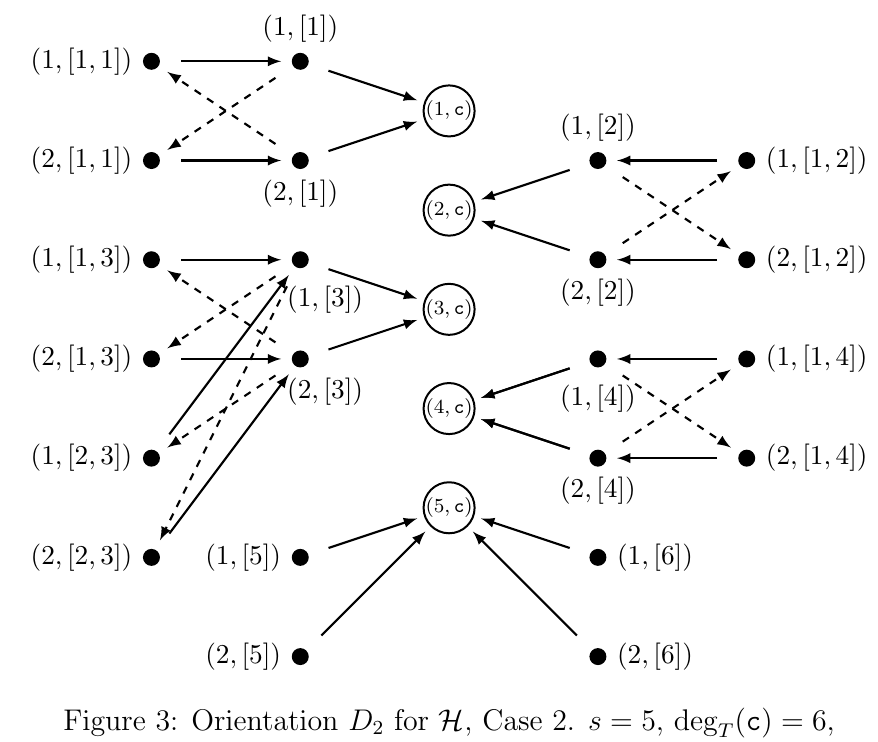
Figure 3: Orientation D